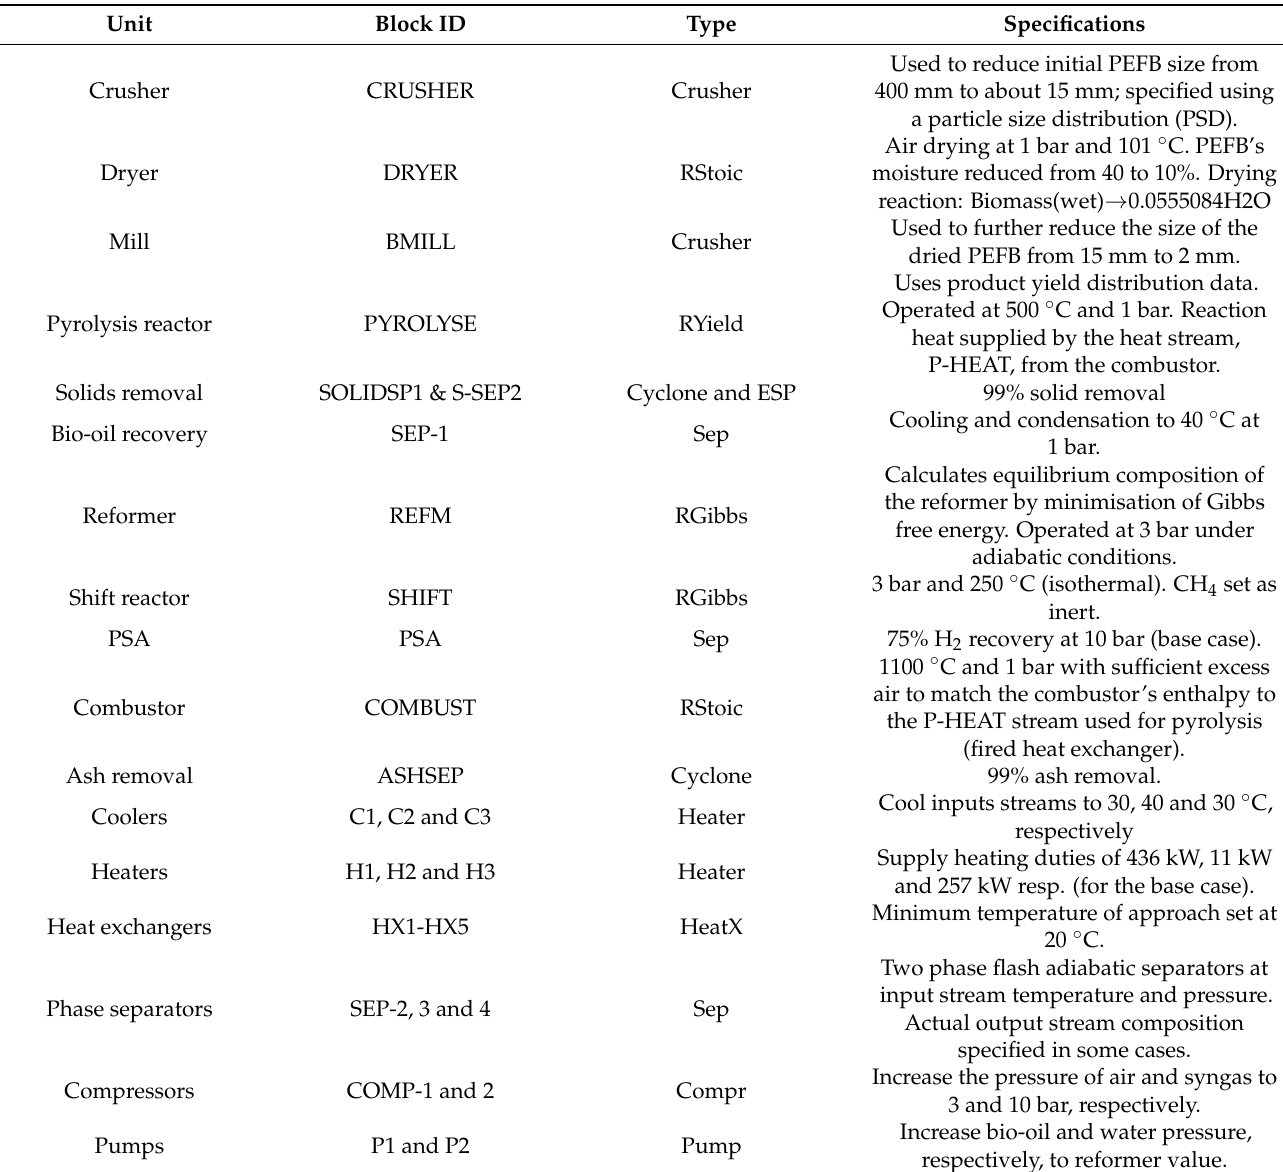
Table 3. Aspen Plus unit blocks used for the simulation and their